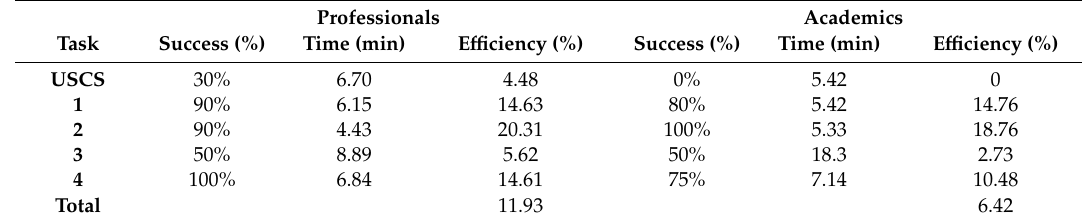
Table 4. E ffi ciency between professionals and